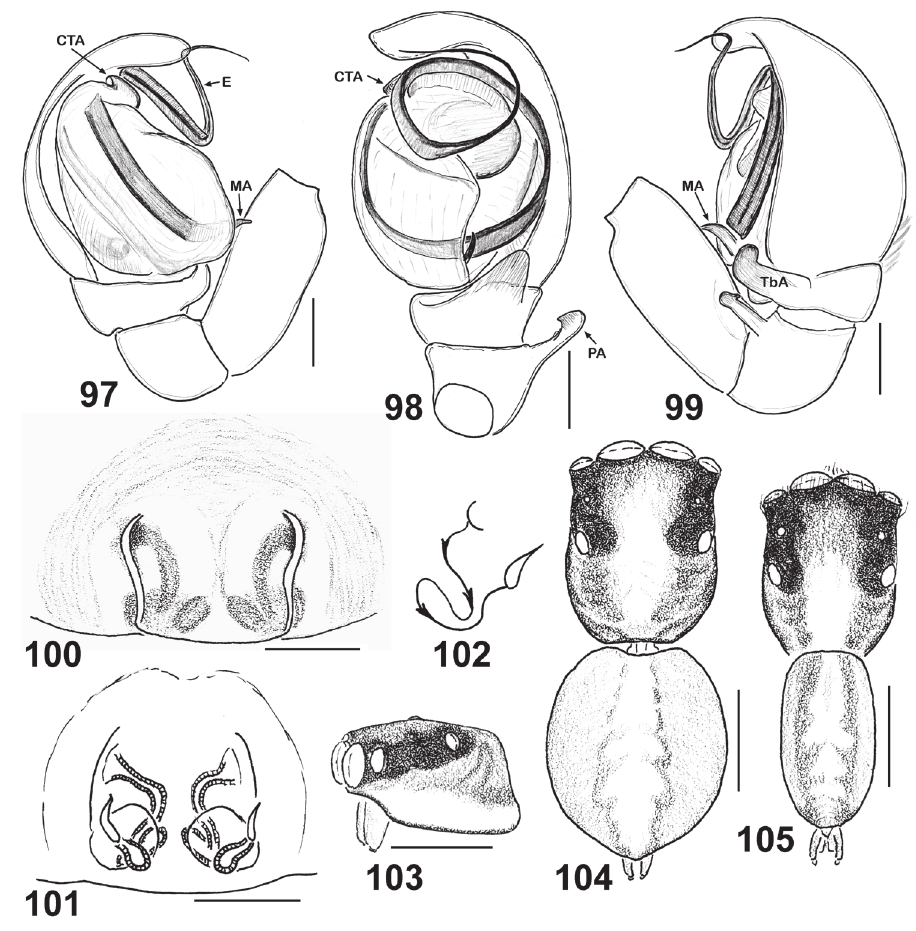
Figures 97–105. Copulatory organs and somatic characters of Eupoa schwendingeri sp. n. ( ♂ and ♀ paratypes). 97 male palp, median view 98 ditto, ventral view 99 ditto, retrolateral view 100 epigyne, ventral view 101 vulva, dorsal view 102 diagrammatic course of insemination ducts 103 female carapace, lateral view 104 female body, dorsal view 105 male body, dorsal view. Abbreviations as explained in ‘Material and methods’. Scale bars: 0.1 mm ( 97–101 ), 0.25 mm ( 103–105